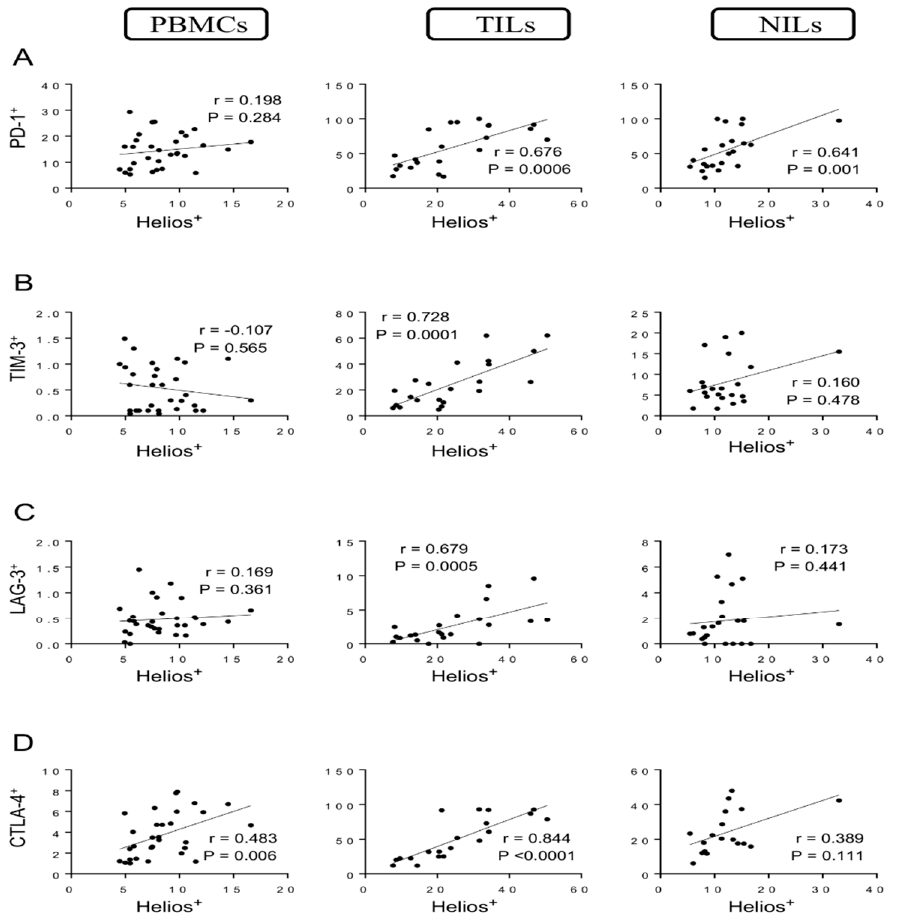
Figure 2. Correlations between levels of Helios and immune checkpoints in CD4 + T cells in CRC patients. Correlations between levels of CD4 + Helios + T cells with PD-1 + ( A ), TIM-3 + ( B ), LAG-3+ ( C ), and CTLA-4 + ( D ) in PBMCs, TILs, and NILs.